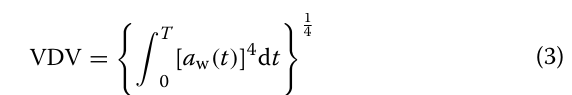
Vibration dose value (VDV) VDV is the fourth power of acceleration time histories. It is expressed by Eq. (3)—